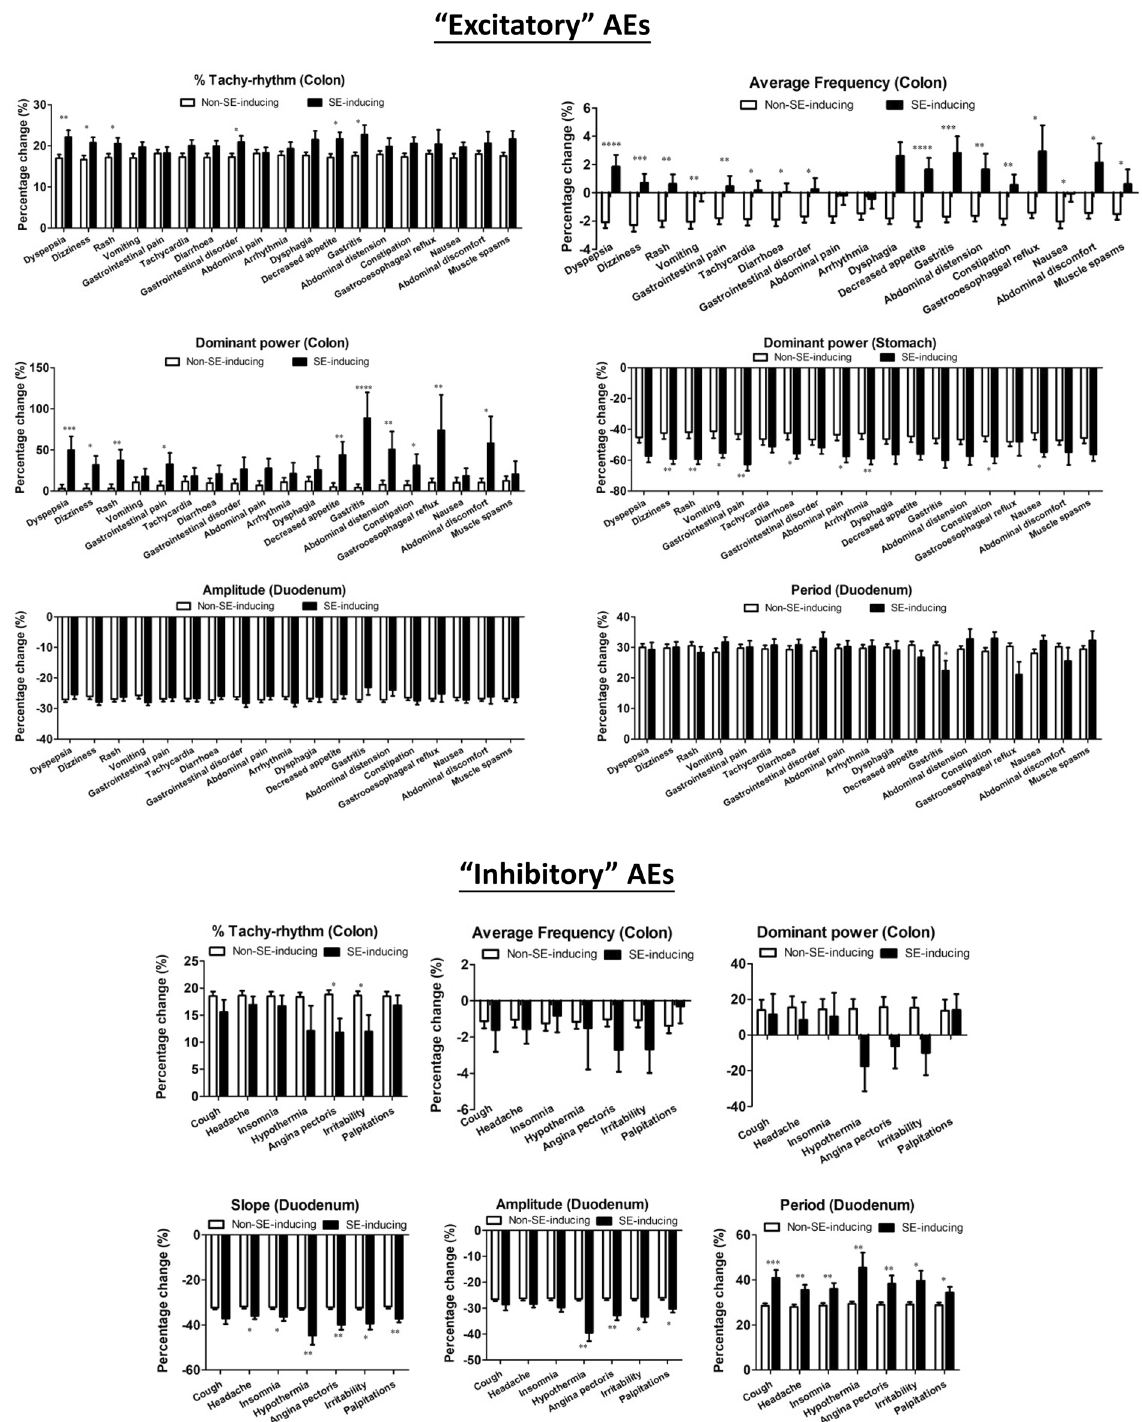
Figure 3. Excitatory and Inhibitory correlations to GI pacemaker activity in selected-AEs. The percentage change of selected features in various AE-inducing drugs and non-AE-inducing drugs. Data represents the mean ± S.D. Significant differences are indicated as *p < 0.05, **p < 0.01, ***p < 0.001 using unpaired t-tests (n =